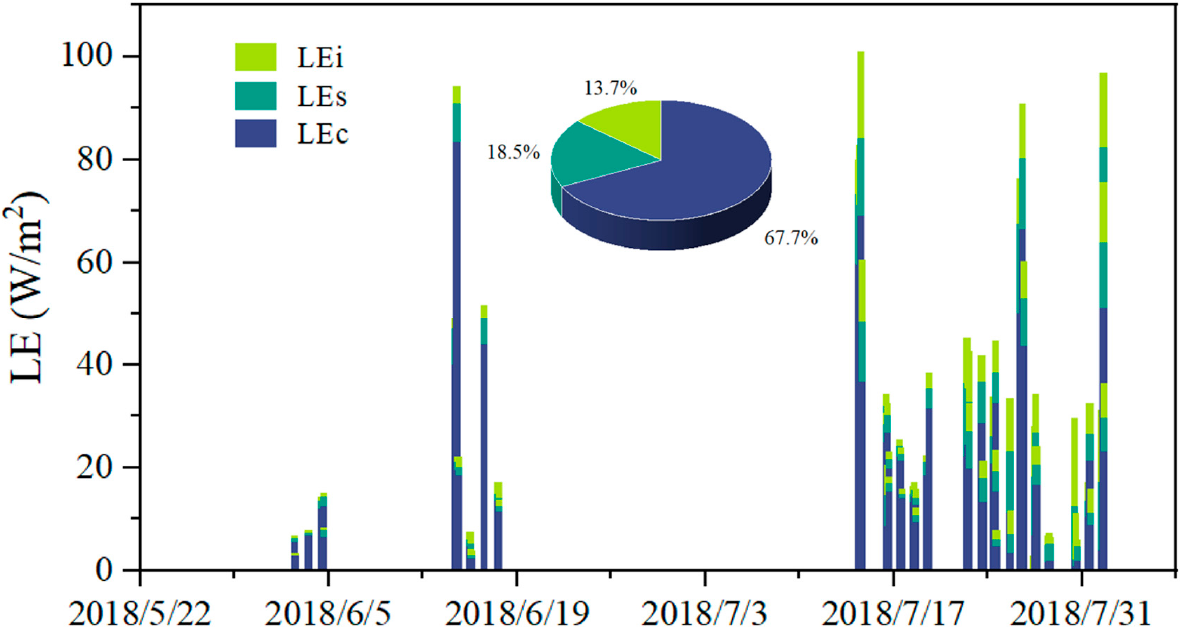
Figure 10. Histogram showing the half-hourly estimated canopy interception evaporation (LEi), soil evaporation (LEi), and canopy transpiration (LEc) during the study period. The inserted pie chart shows the proportions of each component in the total LE during the study period.